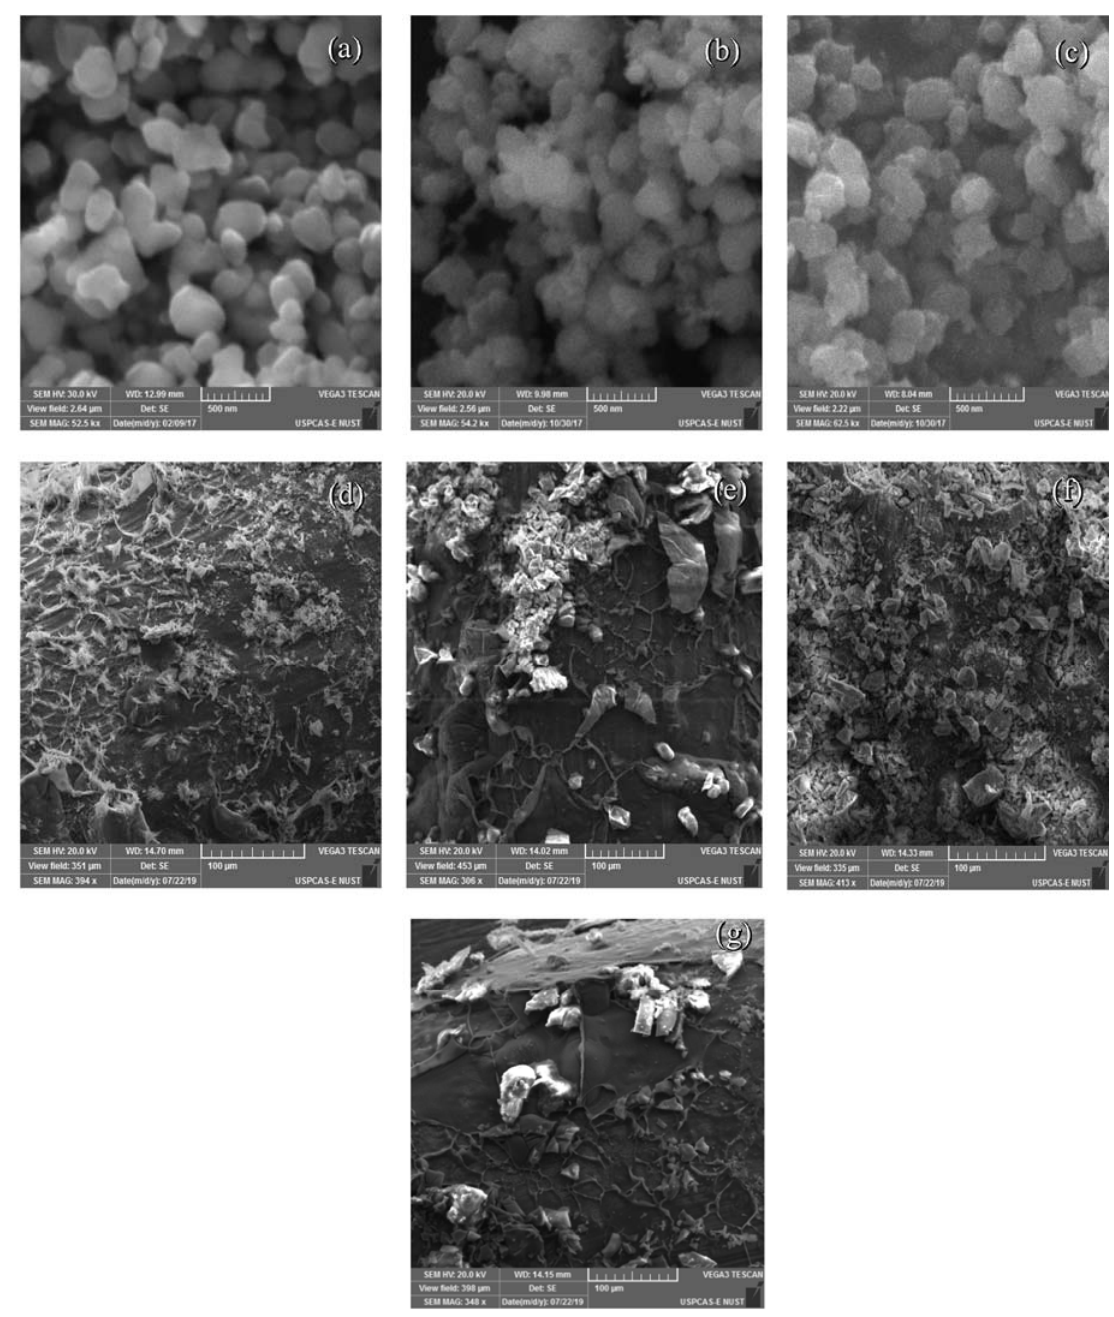
Figure 2. SEM images of ( a ) TiO 2 nanoparticles ( b ) Co 3 O 4 /TiO 2 ( c ) 8 wt.% ZrO 2 ‐ Co 3 O 4 /TiO 2 ( d ) Bef test 8 wt.% ZrO 2 ‐ Co 3 O 4 /TiO 2 coated wire ( e ) Aft test 8 wt.%. ZrO 2 ‐ Co 3 O 4 /TiO 2 coated wire ( f ) Bef test 8 wt.% ZrO 2 ‐ Co 3 O 4 /TiO 2 coated wire ( g ) Aft test 8 wt.% ZrO 2 ‐ Co 3 O 4 /TiO 2 .